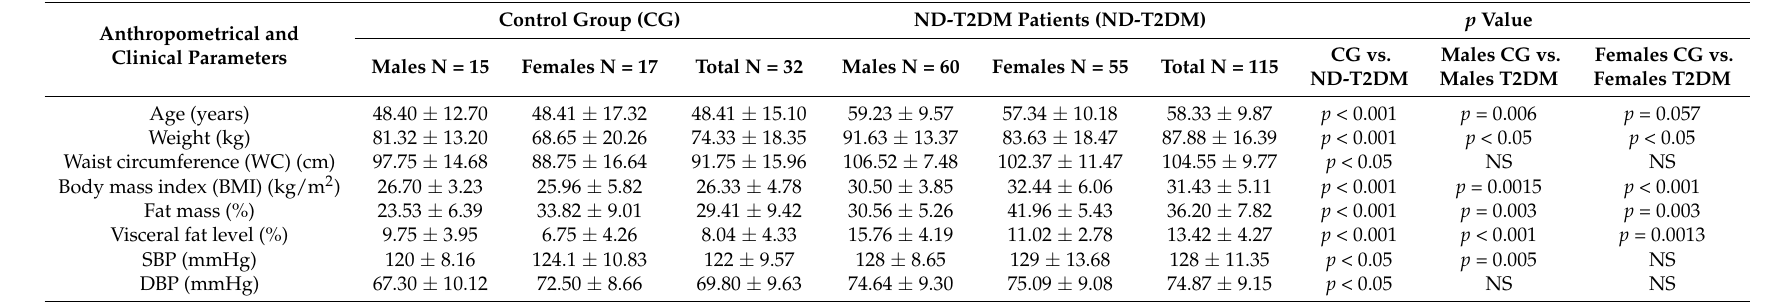
Table 1. The values for anthropometric and clinical parameters for control group and T2DM